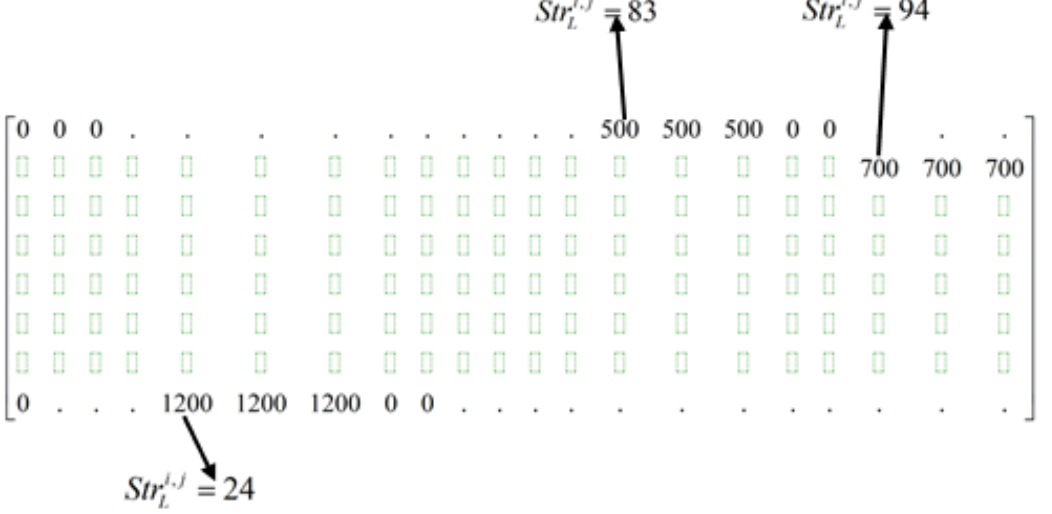
based on stat set L 1